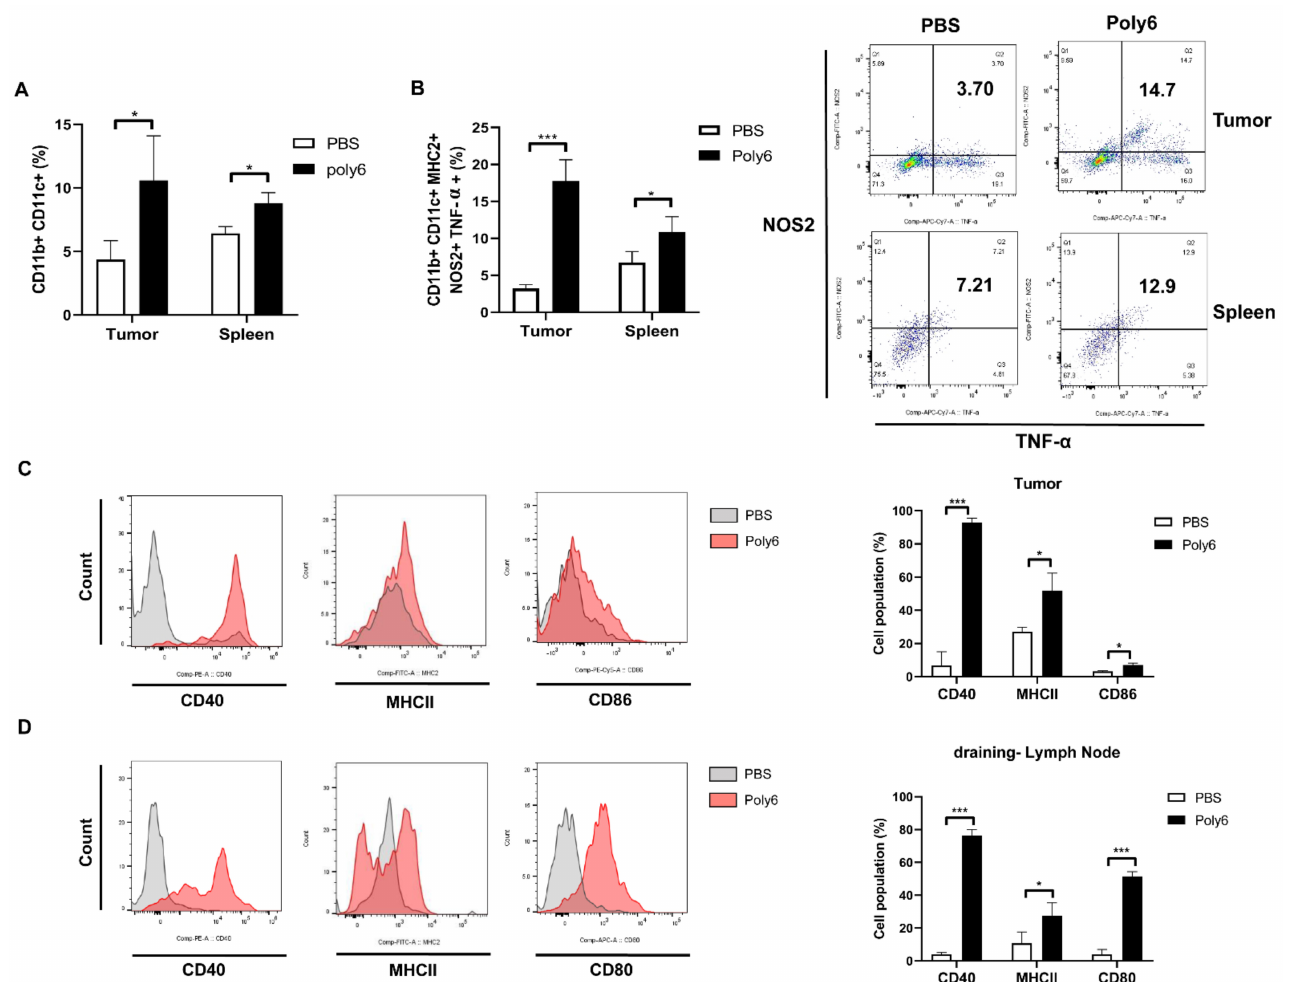
Figure 4. Poly6 induces generation of TNF-a/iNOS-producing DCs (Tip-DCs) and CD40 activation of DCs. ( A ) Populations of CD11b+ CD11c+ dendritic cells in tumor tissue and spleen from MC38-bearing mice were analyzed by FACS. ( B ) Intracellular cytokines (TNF- α +, NOS2+) and surface markers (CD11b+, CD11c+, MHC II +) were stained, and this population was termed Tip-DCs. The population of Tip-DCs in tumor tissues and splenocytes from MC38-bearing mice was analyzed by FACS. ( C ) In tumor tissue and ( D ) draining lymph nodes, maturation markers for dendritic cells were analyzed. CD40, MHC II, and CD86 markers were evaluated in tumors, and CD40, MHC II, and CD80 markers were assessed in the lymph nodes by FACS analysis. Significance differences (* p < 0.05 and *** p < 0.001) among different groups are shown in related figures, and the data are presented as the mean ± standard error of mean (SEM). of the mice ( n = 4). Student’s t -test were